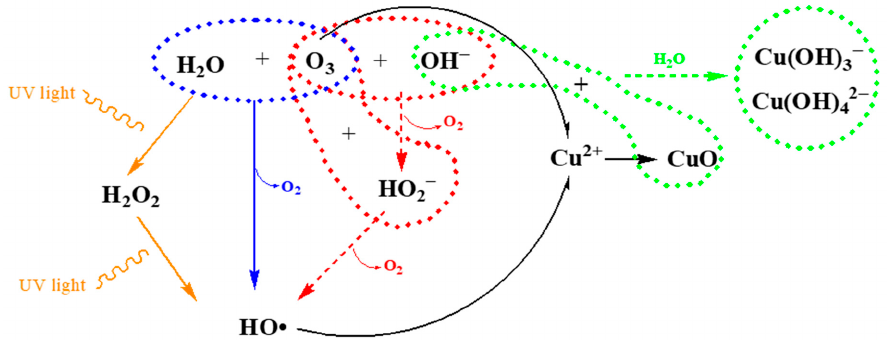
Figure 11. Proposed mechanism of Cu removal from electroplating wastewater through UV-Ozone